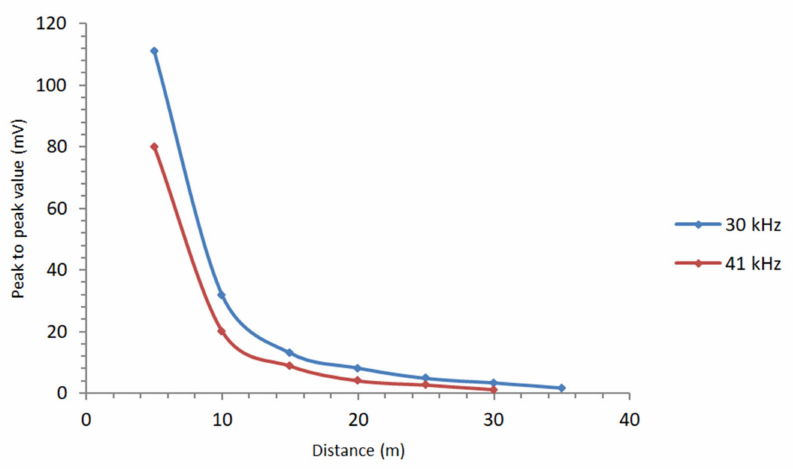
Figure 10. Averaged voltages recorded in the receiver (AR30 and AR41